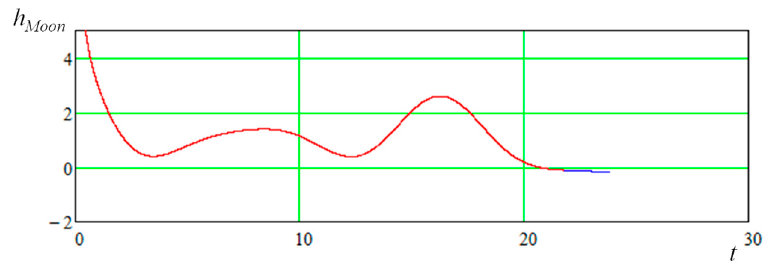
Figure 26. Optimal low-energy two-impulse SC flight trajectory from a 200 km low Earth reference orbit to a 100 km low selenocentric circular orbit.